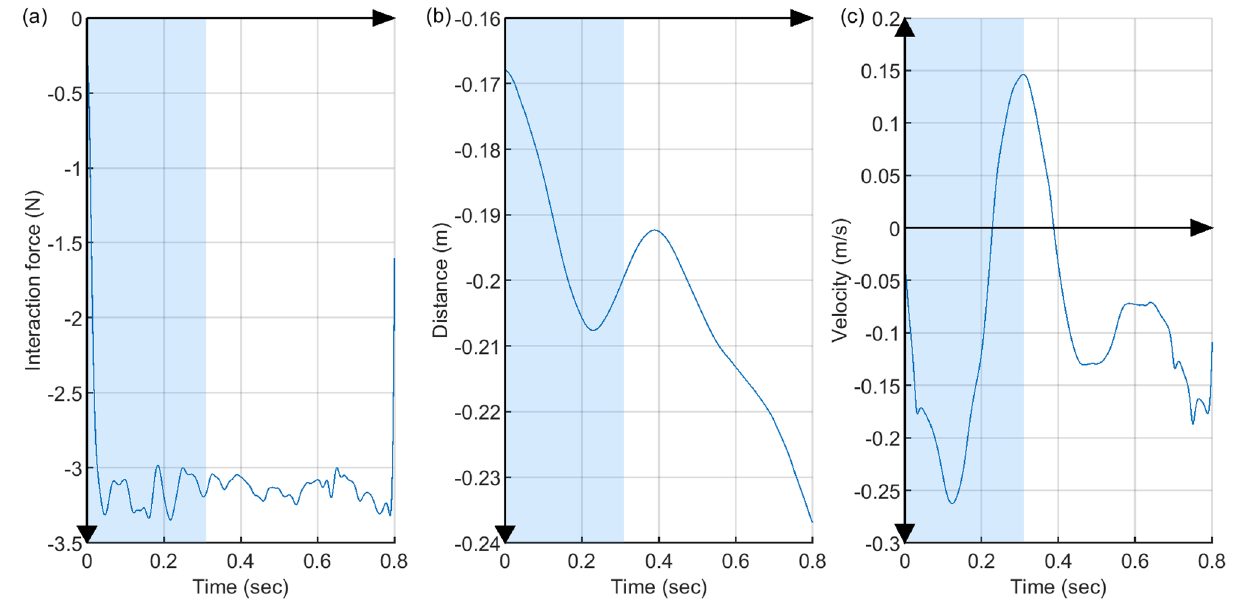
Figure 8. Measurements during the 800 ms perturbation of a representative trial of a subject. The shaded area represents the time stamp from the perturbation onset to the time of second peak in the velocity plot. The data from this shaded region was used to estimate the arm stiffness. ( a ) The interaction force between the robot arm and the human subject. ( b ) The position of the hand with respect to the origin of the workspace in y-direction. ( c ) The velocity of the hand in